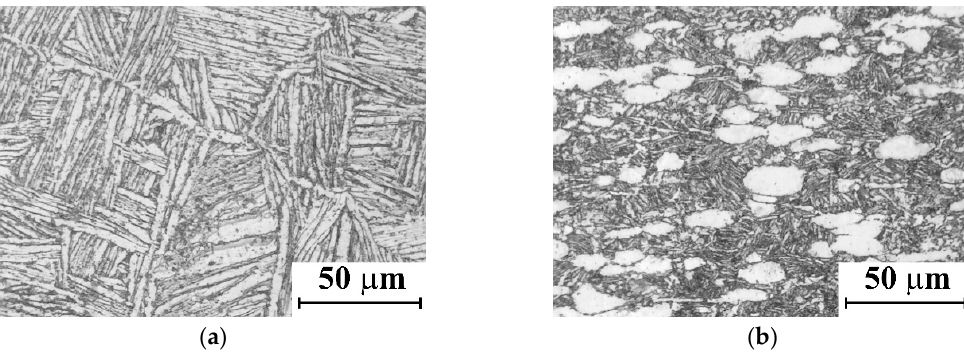
Figure 2. Lamellar ( a ) and bimodal ( b ) microstructures of Ti-6Al-4V alloy samples.